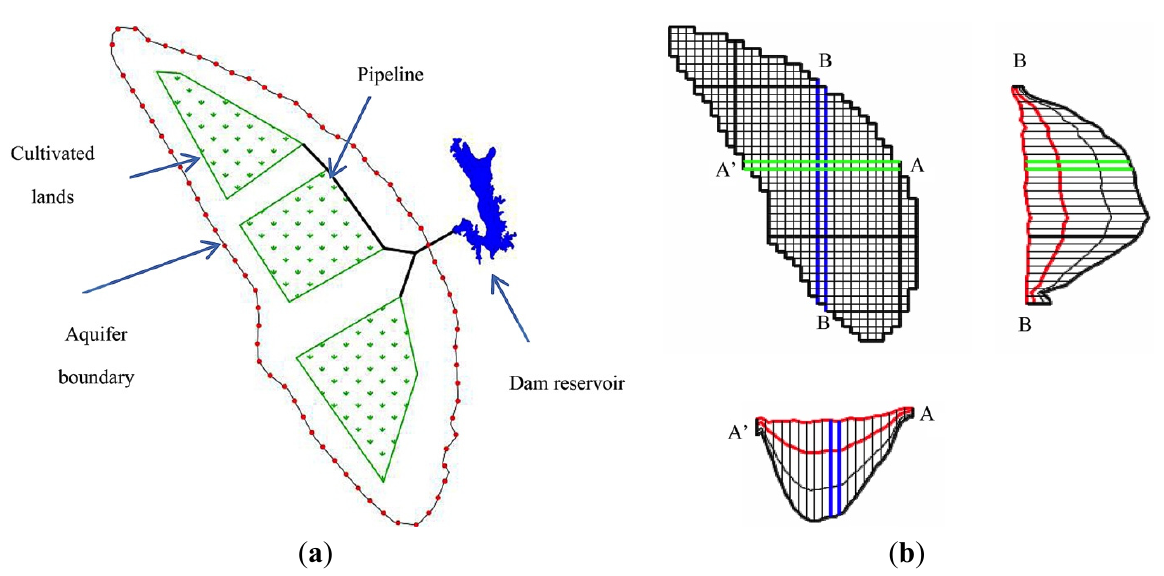
Figure 9. ( a ) Schematic view of the proposed system, consisting of the dam, agricultural areas within the aquifer boundaries and a pipeline to convey water from the dam to agricultural areas; ( b ) discretization of the aquifer system and its side